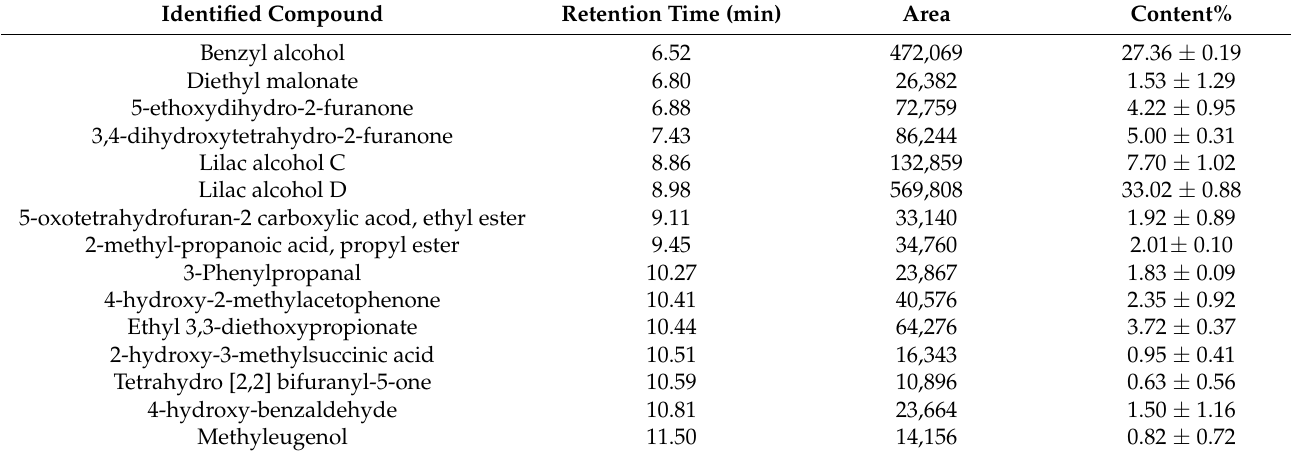
Table 5. The tentative identification of the main compounds in S. vulgaris flowers extract by GC-MS analysis. Identified